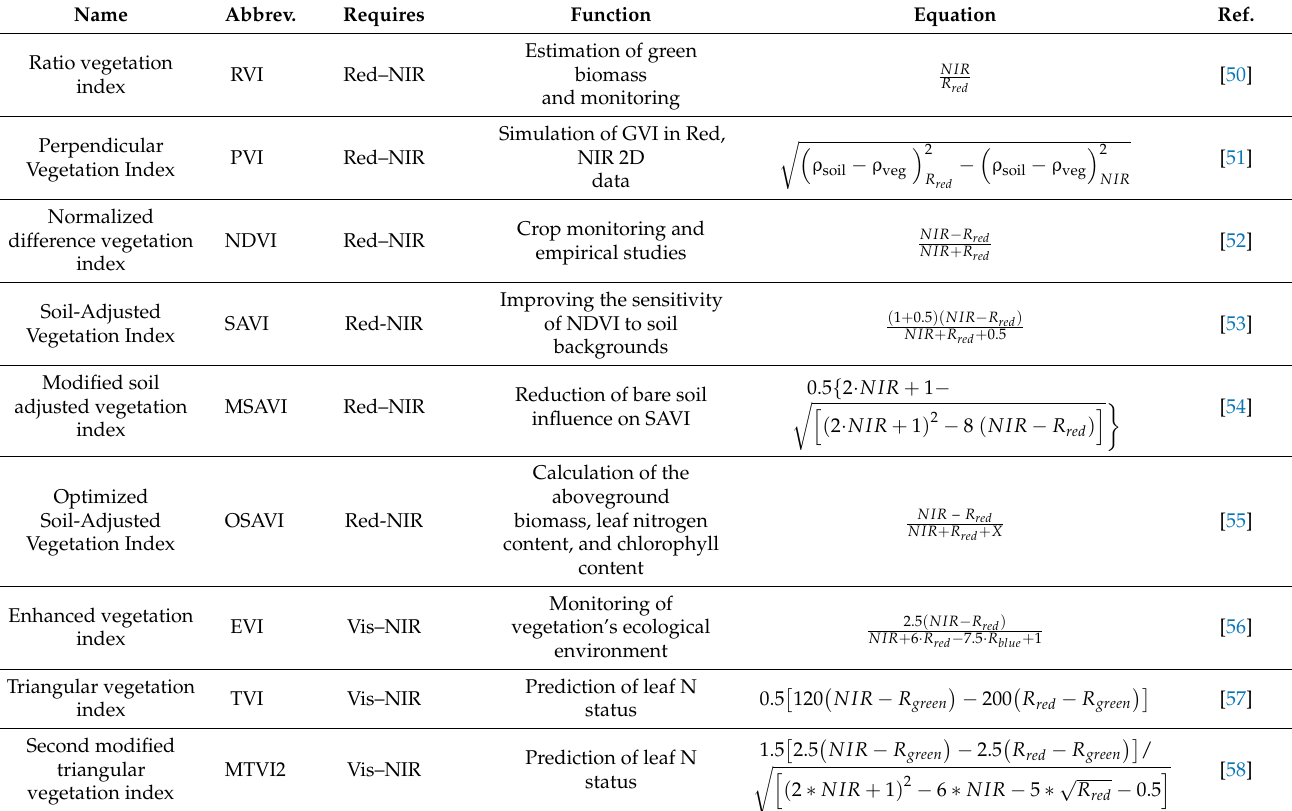
Table 3. Summary of commonly used Vegetation Indices